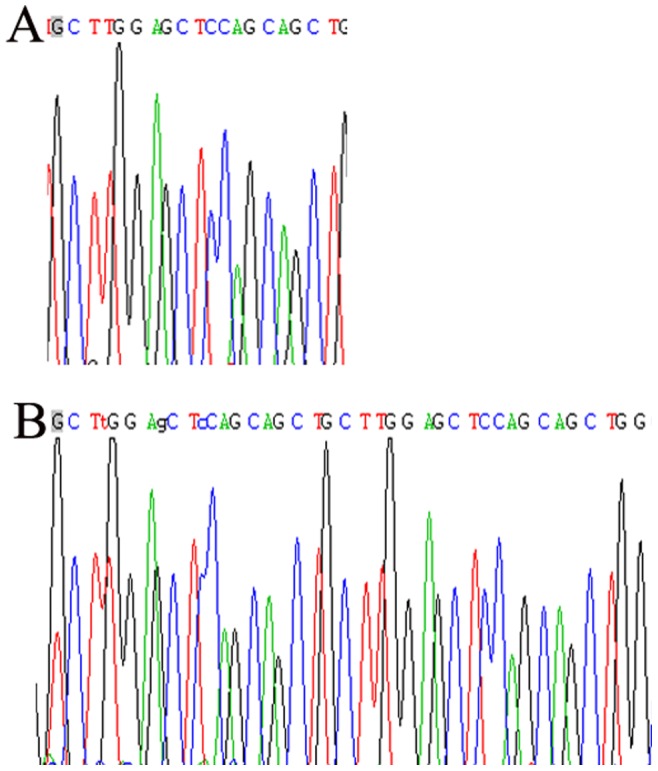
The sequencing results of PCR products.(A). LAPTM4B*1; (B).LAPTM4B*2.